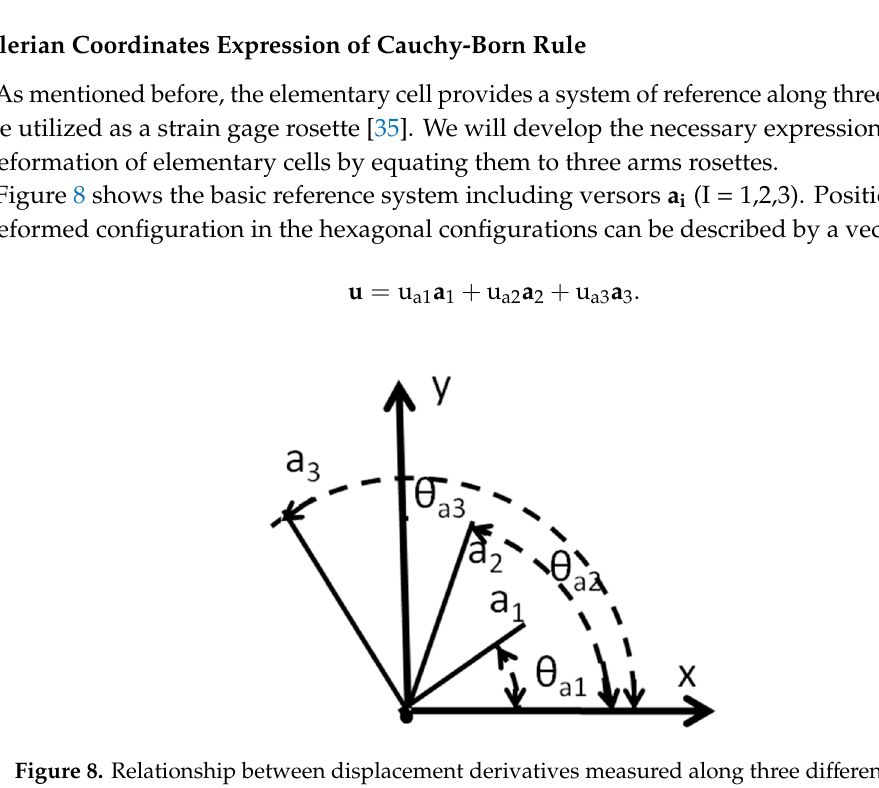
Figure 8. Relationship between displacement derivatives measured along three different versors.